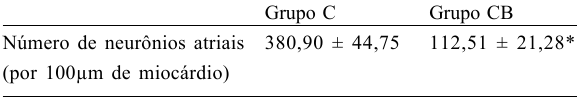
Tabela 3. Resultados da contagem neuronal.